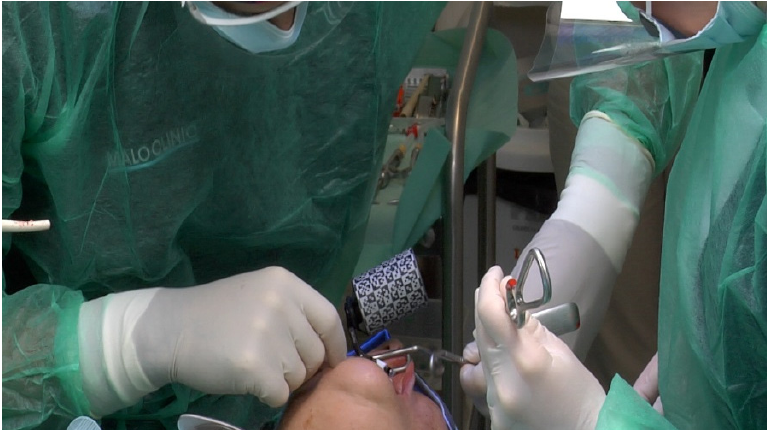
Figure 7. Perioperative photograph illustrating the fixation of the X-Guide clip receptor and array.